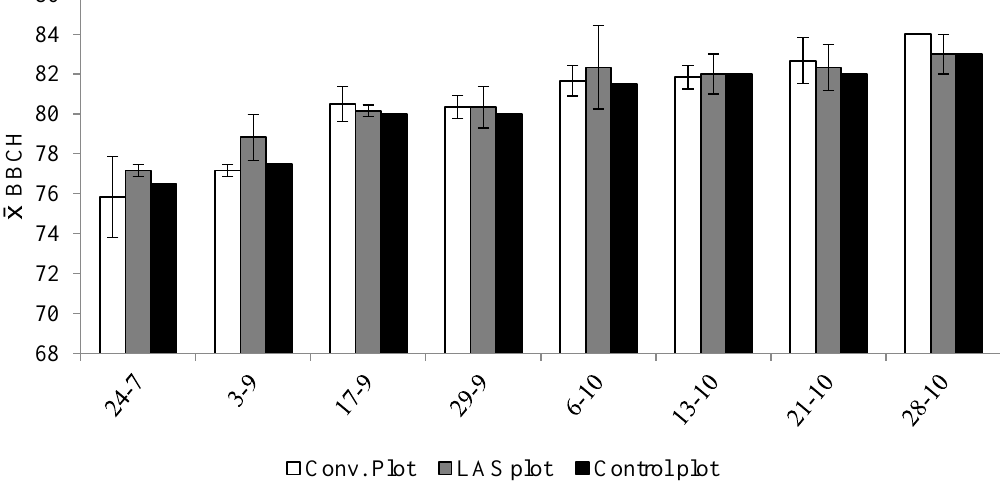
Figure 16. Average of the BBCH scale ± S.D. indicating the phenology of the olive trees within the NO-LAS, LAS, and control plots.